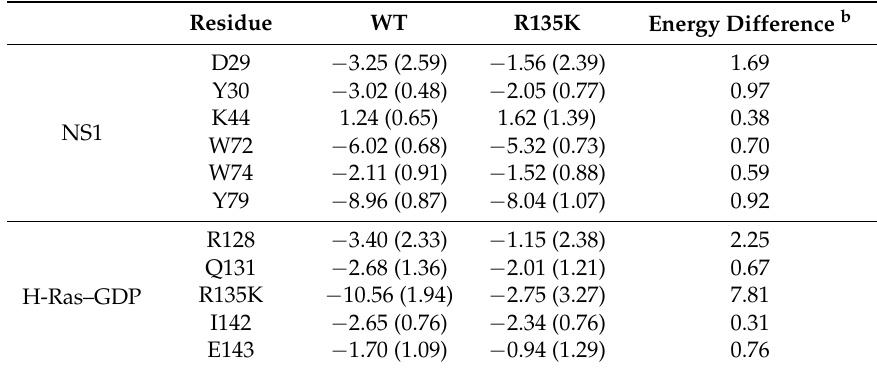
Table 3. Free energy contribution (kcal/mol) by residue and the corresponding free energy difference of H-Ras–NS1–GDP a